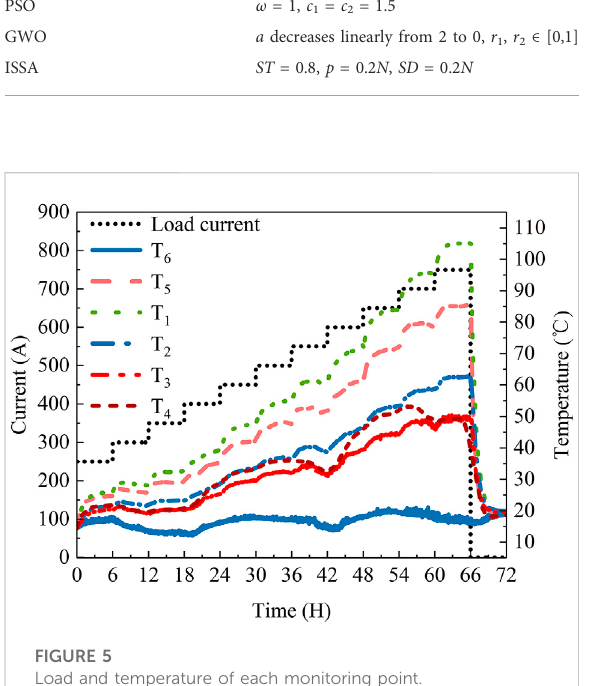
FIGURE 5 Load and temperature of each monitoring